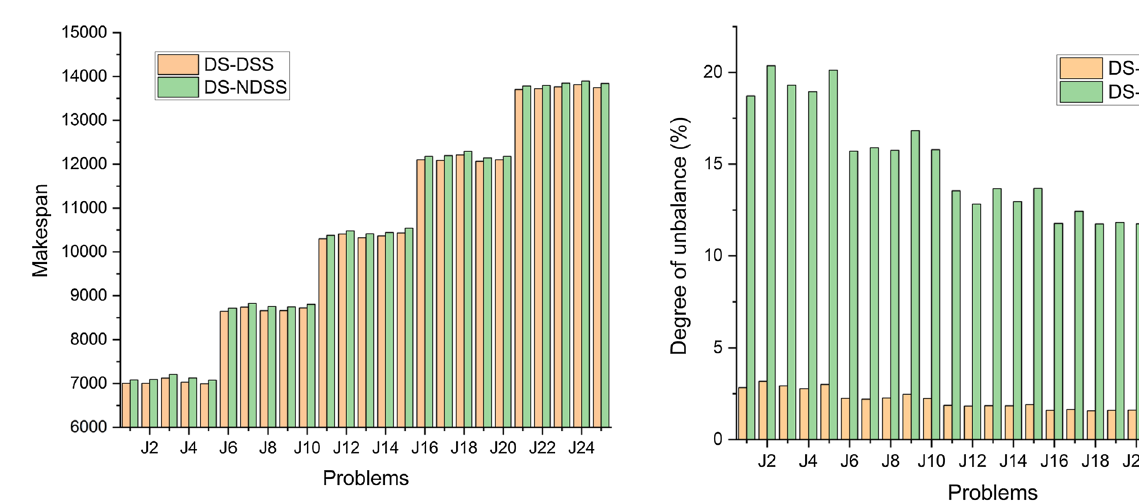
Fig. 13 The degree of unbalance of DS-DSS and DS-NDSS